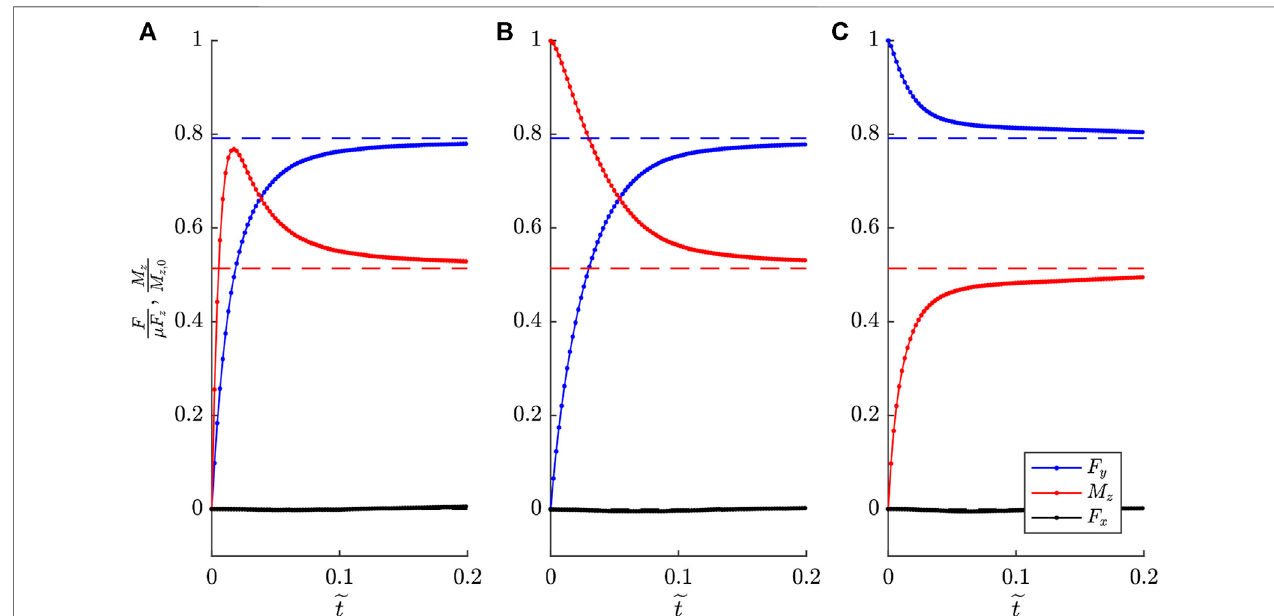
FIGURE 5 | Coef fi cient of friction regarding Forces and torque of a Hertzian Indenter which is displaced and rotated simultaneously at ~ v (cid:2) 0 . 8. Dashed lines represent theoretical prediction according to Eqs 21 and 22 . Initial conditions were (A) full stick without tangential stress, (B) full rotational slip without lateral displacement and (C) full lateral slip, no